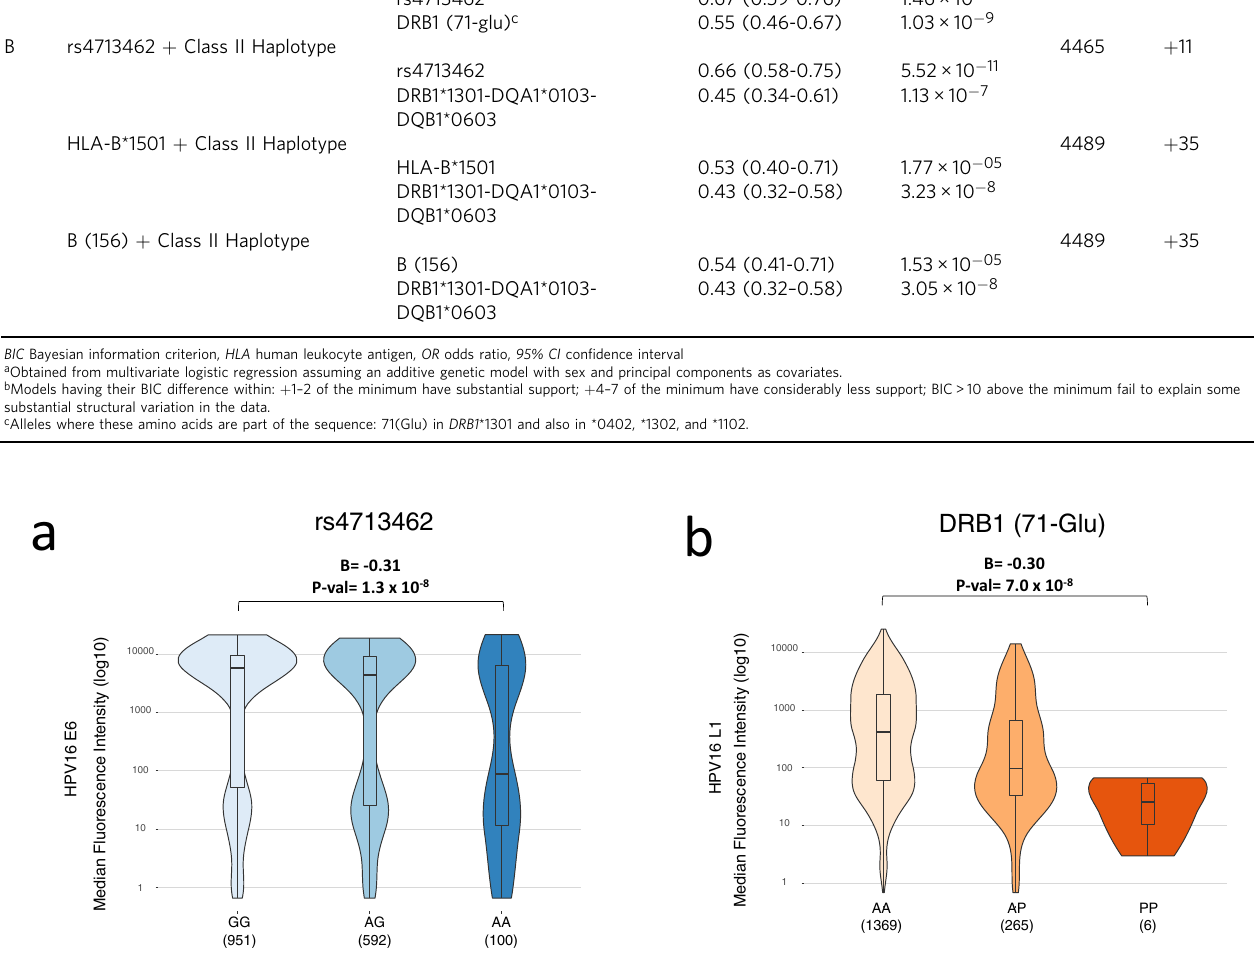
Fig. 3 pQTL analysis of plasma antibody levels against HPV proteins of the top two associated HPV( + )OPC HLA variants. Box plots showing a HPV16 E6 MFI levels and rs4713462 genotypes, and b HPV16 L1 MFI levels and DRB1 (71-Glu) variants in OPC cases. Effect sizes (B, regression coef fi cient) were adjusted for age, sex, and eigenvectors. For HLA-DRB1 71-Glu, A stands for absence and P stands for presence. Box plots show the medians (center lines) and the 25th and 75th percentiles (box edges), with whiskers extending to 1.5 times the interquartile range. Linear multivariate models were implemented to test associations of genetic variants across the MHC region with HPV16 L1 or E6 log-transformed MFI levels, assuming a dosage model with age, sex and eigenvectors as covariates. HLA human leukocyte antigen, pQTL protein Quantitative Trait Loci, HPV human papillomavirus, OPC oropharyngeal cancer, MFI median fl uorescence